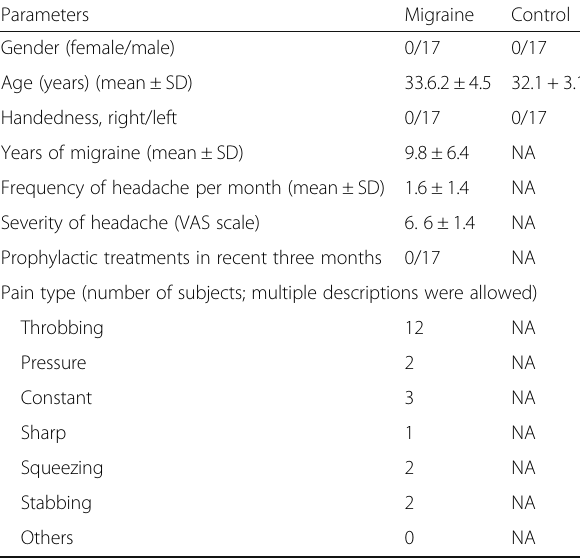
Table 1 Clinical Characteristics of